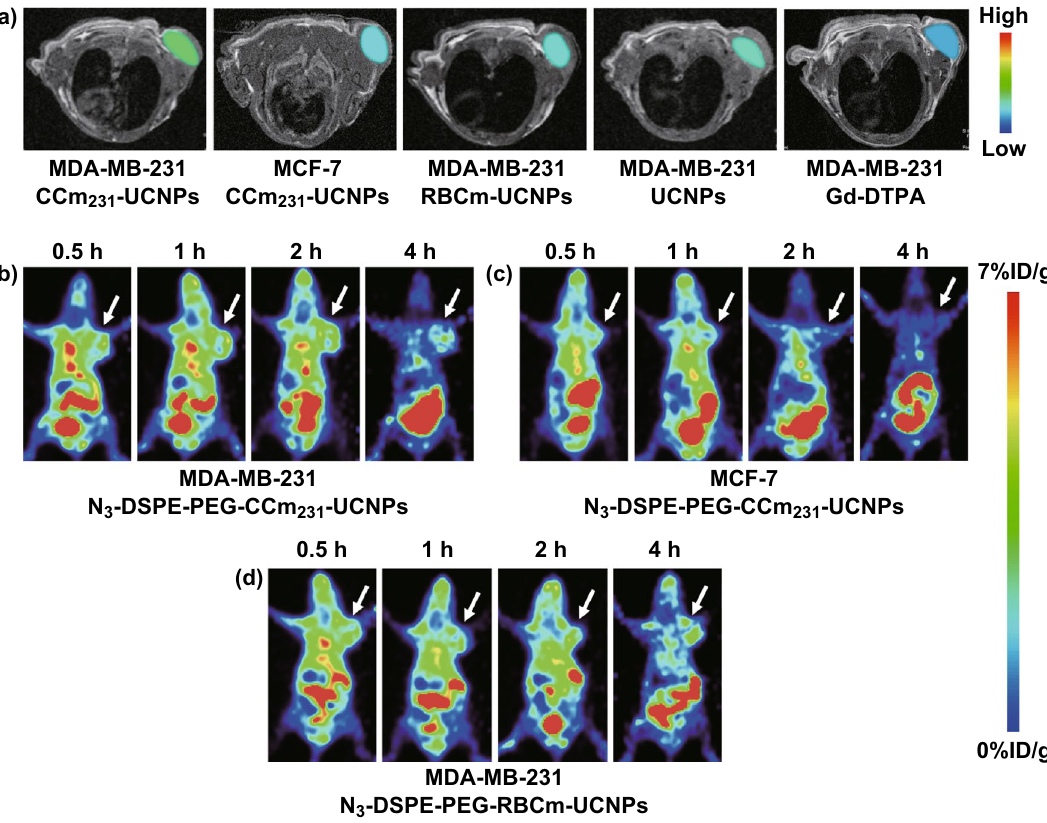
Fig. 3 In vivo MR imaging. T1‑weighted MR images acquired at 24 h after the injection of nanoparticles. a BALB/c nude tumor‑bearing mice injected with Gd‑DTPA or PBS containing CCm 231 ‑UCNPs, RBCm‑UCNPs, UCNPs. The tumor sites are color‑coded to better show the con‑ trast‑enhancing effects. In vivo PET imaging. Micro‑PET static imaging was performed at 0.5, 1, 2, and 4 h after injection of Al[ 18 F]F‑L‑ NETA‑DBCO. b MDA‑MB‑231 tumor‑bearing mice injected with N 3 ‑DSPE‑PEG‑CCm 231 ‑UCNPs. c MCF‑7 tumor‑bearing mice injected with